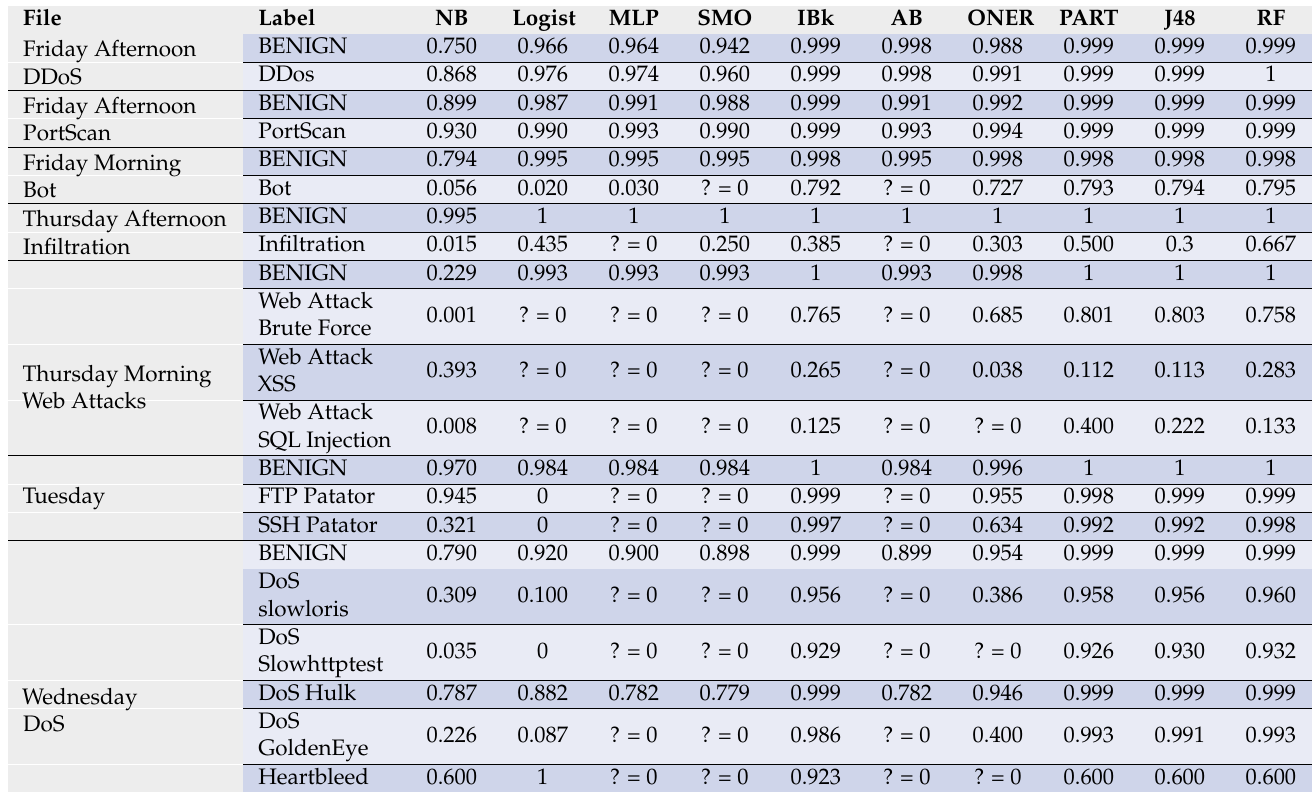
Table 15. F1 performance results in multiclass classification using attributes